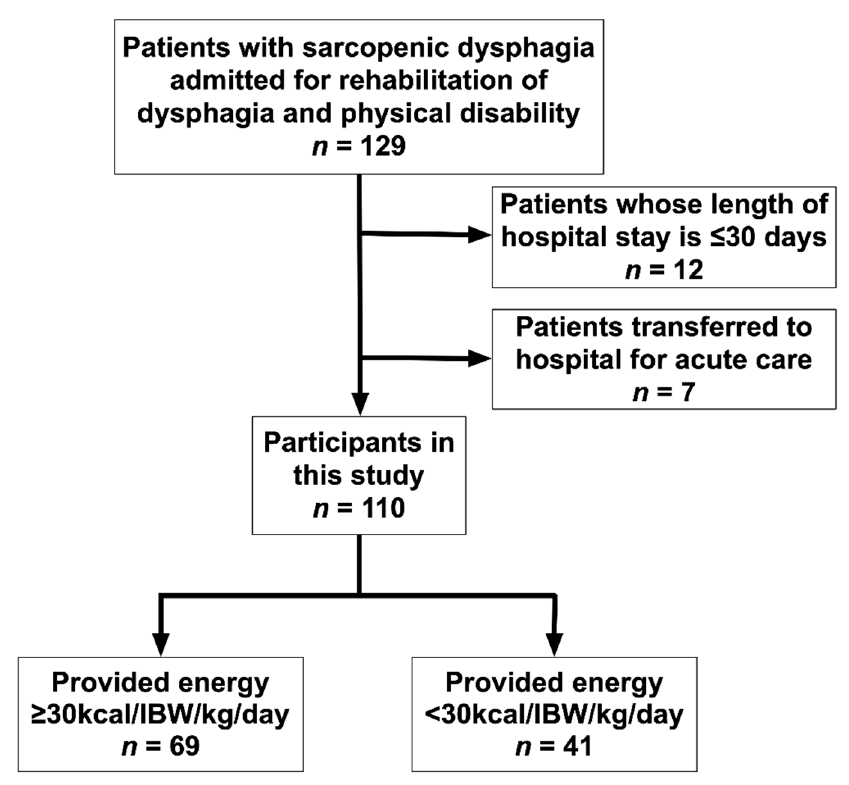
Figure 1. Flowchart of the study participant selection process. Patients with sarcopenic dysphagia aged ≥ 65 years ( n = 129) were examined for participation eligibility. Finally, 110 patients were included in the study. Table 1. Comparison of baseline variables in the crude